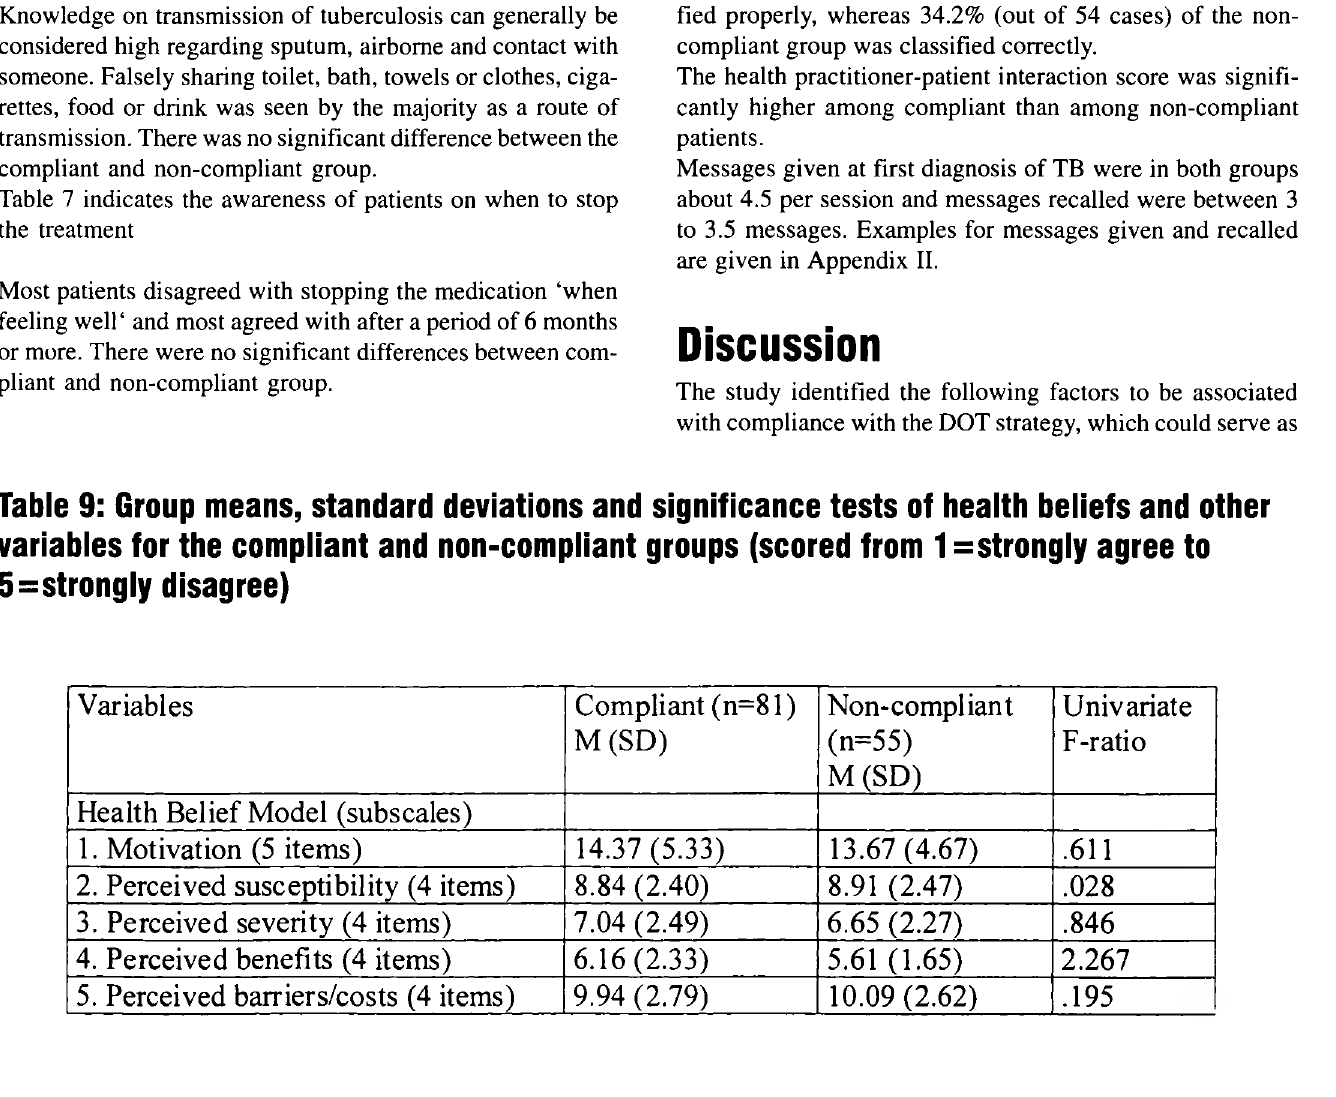
Table 7 indicates the awareness of patients on when to stop the treatment